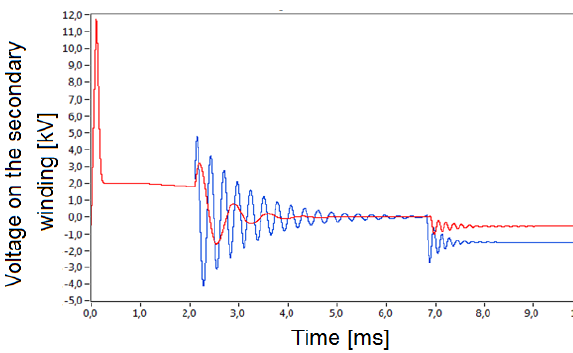
Fig. 5. Changes in the ignition voltage course on the secondary side in the event of a high voltage break in the circumference of the candle